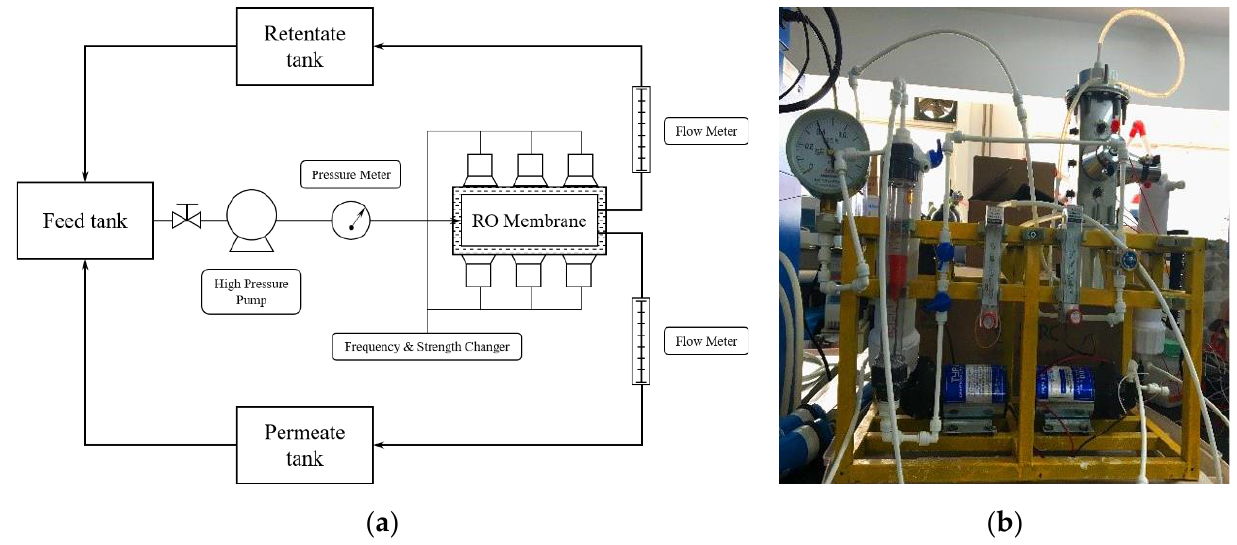
Figure 1. Schematic ( a ) and photograph ( b ) of the laboratory-scale membrane system.